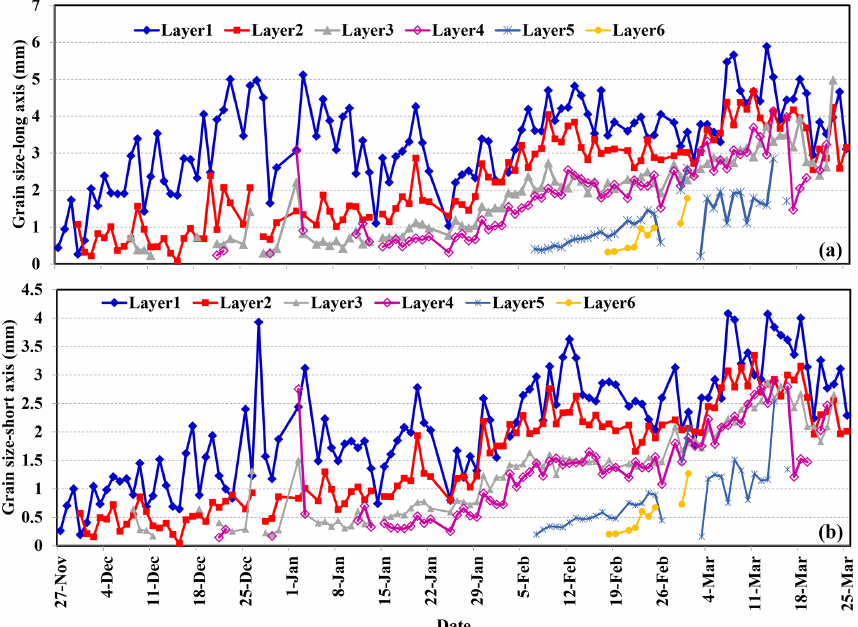
Figure 8. Daily variation in grain size within each layer from 27 November 2015 to 25 March 2016. The layer thicknesses are presented in Fig.